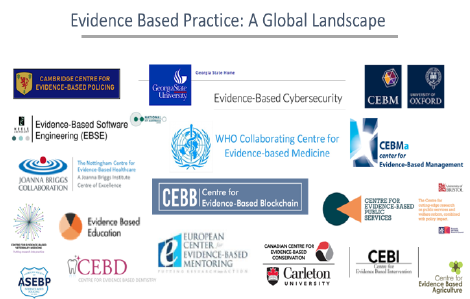
Figure 1. Centres of Evidence-Based Practice